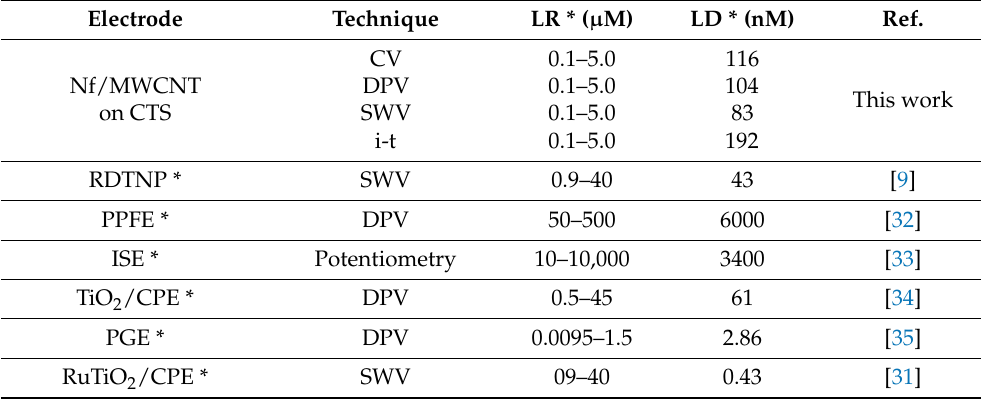
Table 1. Comparison of the performance characteristics of various electrochemical methods for Clz sensors with proposed electrodes.